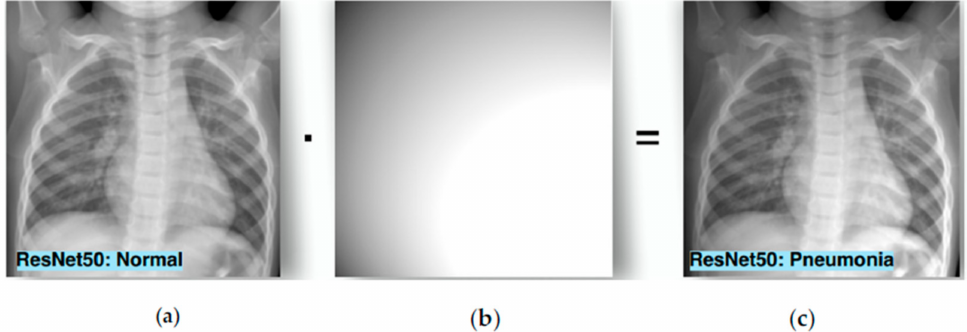
Figure 8. ( a ) A clean image, ( b ) the bias field noise, and ( c ) the diagnosis after implementation of bias field